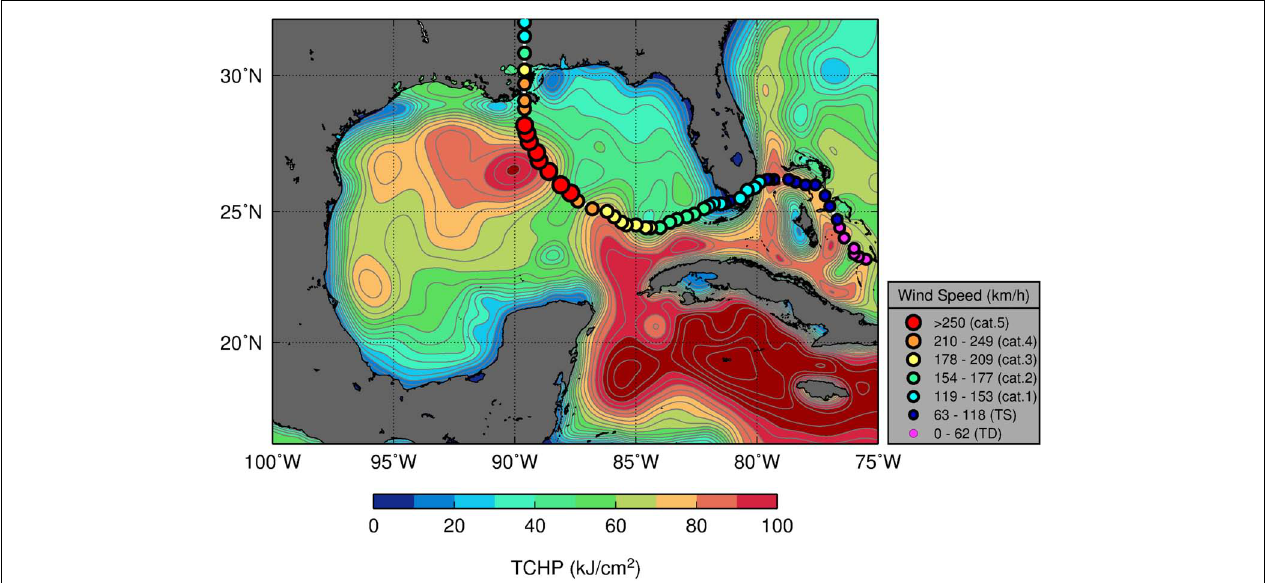
FIGURE 2 | Track of Hurricane Katrina (2005) overlaid on tropical cyclone heat potential (TCHP, upper-OHC) conditions in the Gulf of Mexico on 08/20/2005 (prior to the passage of Katrina). Gray contours are displayed every 5 kJ cm − 2 units.